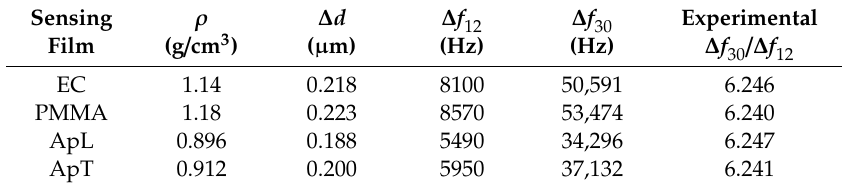
Table 2. Summary of the principal physical characteristics of each sensing film used in this work (density, estimated film thickness, frequency shift, and experimental frequency shifts ratio).